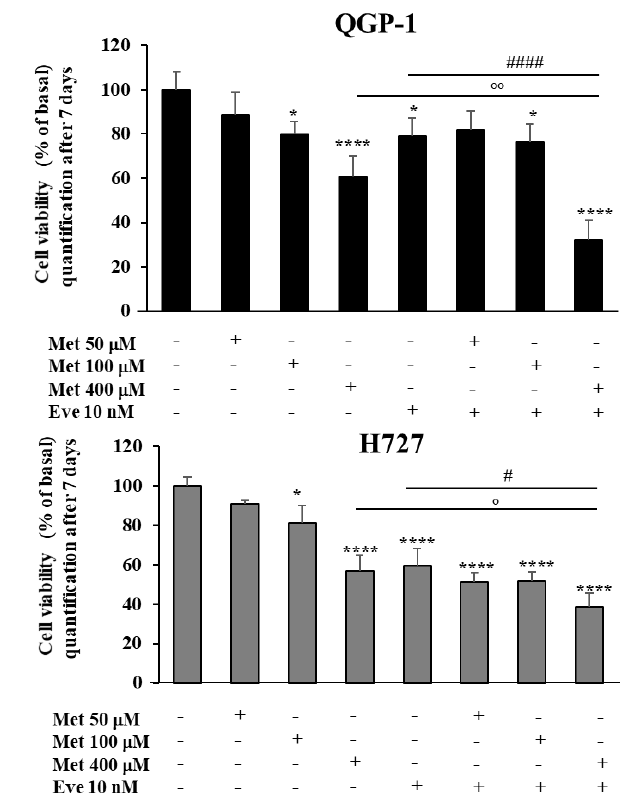
Figure 2. The e ff ect of metformin (Met) and everolimus (Eve) on QGP-1 and H727 cell viability. ( A , B ) Cells were incubated with metformin (50 µ M, 100 µ M and 400 µ M), or treated with everolimus (10 nM), or with the combination of everolimus 10 nM and metformin (50 µ M, 100 µ M and 400 µ M) for 7 days. The combination of metformin 400 µ M and everolimus 10 nM induced a more e ff ective reduction of both cell lines’ viability than each monotherapy. Values represent mean ( ± SD.) * = p < 0.05, **** = p < 0.0001 vs. corresponding basal, # = p < 0.05 and #### = p < 0.0001 vs. everolimus, ◦ = p < 0.05 and ◦◦ = p < 0.01 vs. metformin. Experiments were repeated at least 3 times and each determination